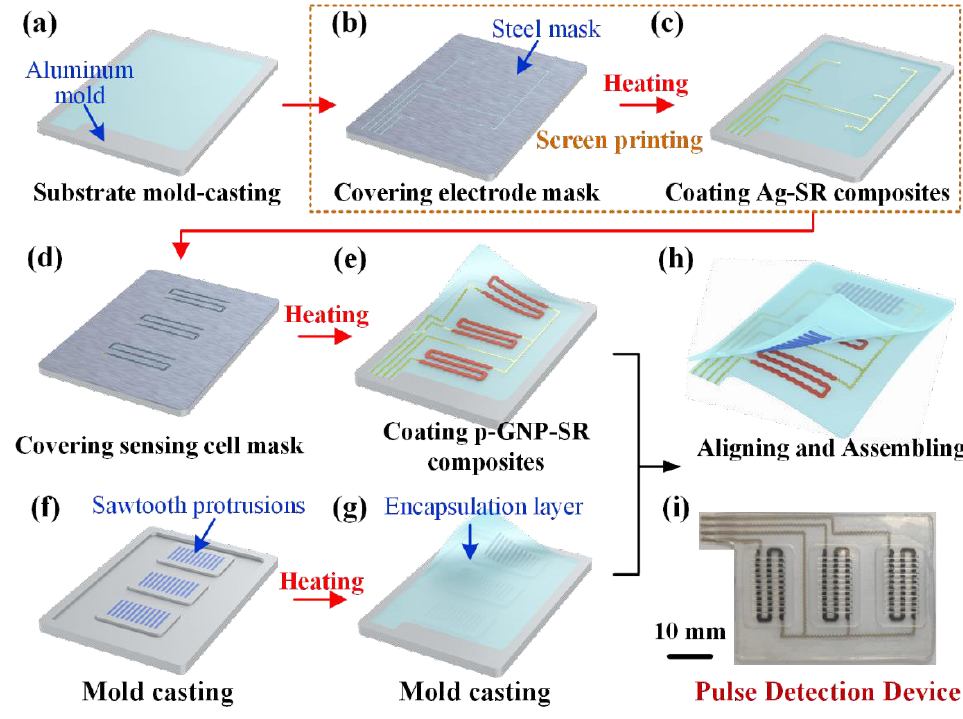
Figure 2. Fabrication process of the wearable pulse detection device: ( a – e ) screen-printing of porous graphene cells and stretchable electrodes; ( f – h ) mold-casting of the upper encapsulation layer and assembly of the pulse detection device; ( i ) image of the final fabricated device.